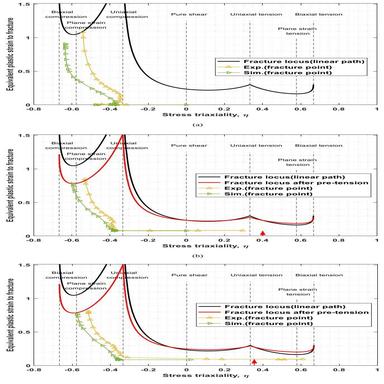
Strain path before compressive fracture of the specimen with (a) no pre-tensile strain, (b) pre-tensile strain of 0.079, and (c) pre-tensile strain of 0.093.